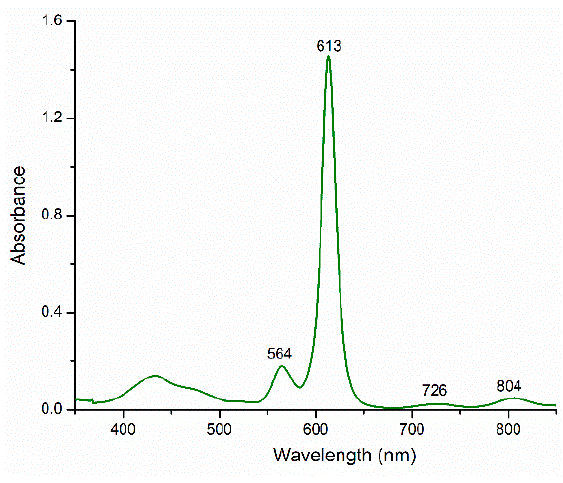
Figure 4. UV ‐ Vis absorption spectra of 4H + •Cl − in CH 2 Cl 2 (conc. = 1.8 × 10 − 6 M). Figure 5 shows a cyclic voltammogram of rosarrin 3 in dichloromethane solution. Rosarrin 3 displayed a typical rosarrin voltammogram with four reversible redox waves with a peak at − 0.73, − 1.13, 0.64 and 0.28 volts. Observed potentials are quite similar to rosarrin 2 [8] which confirms that the post synthetic modulation such as 3 do not change the inherent redox properties and displays same electronic reversibility.